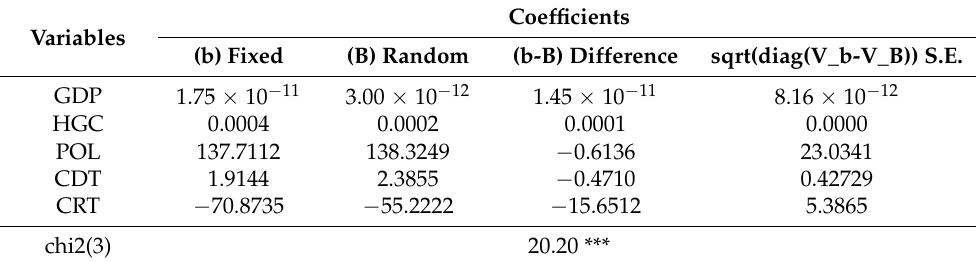
Table 8. Hausman test.